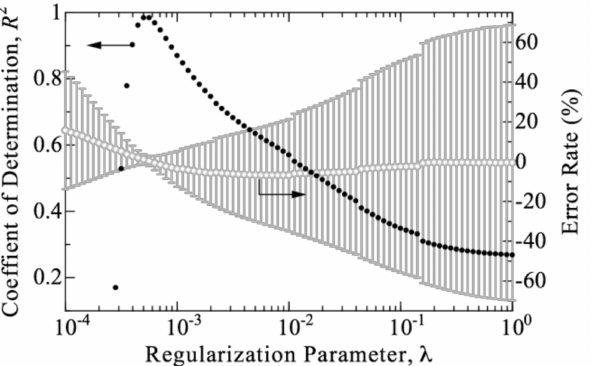
Figure 7. The R 2 value and error rate of the estimated field distribution against the Laplace field obtained by changing the regularization parameter, λ , for the IR used in Figures 5 and 6. The error bar represents the standard deviation of the error rate along the insulation